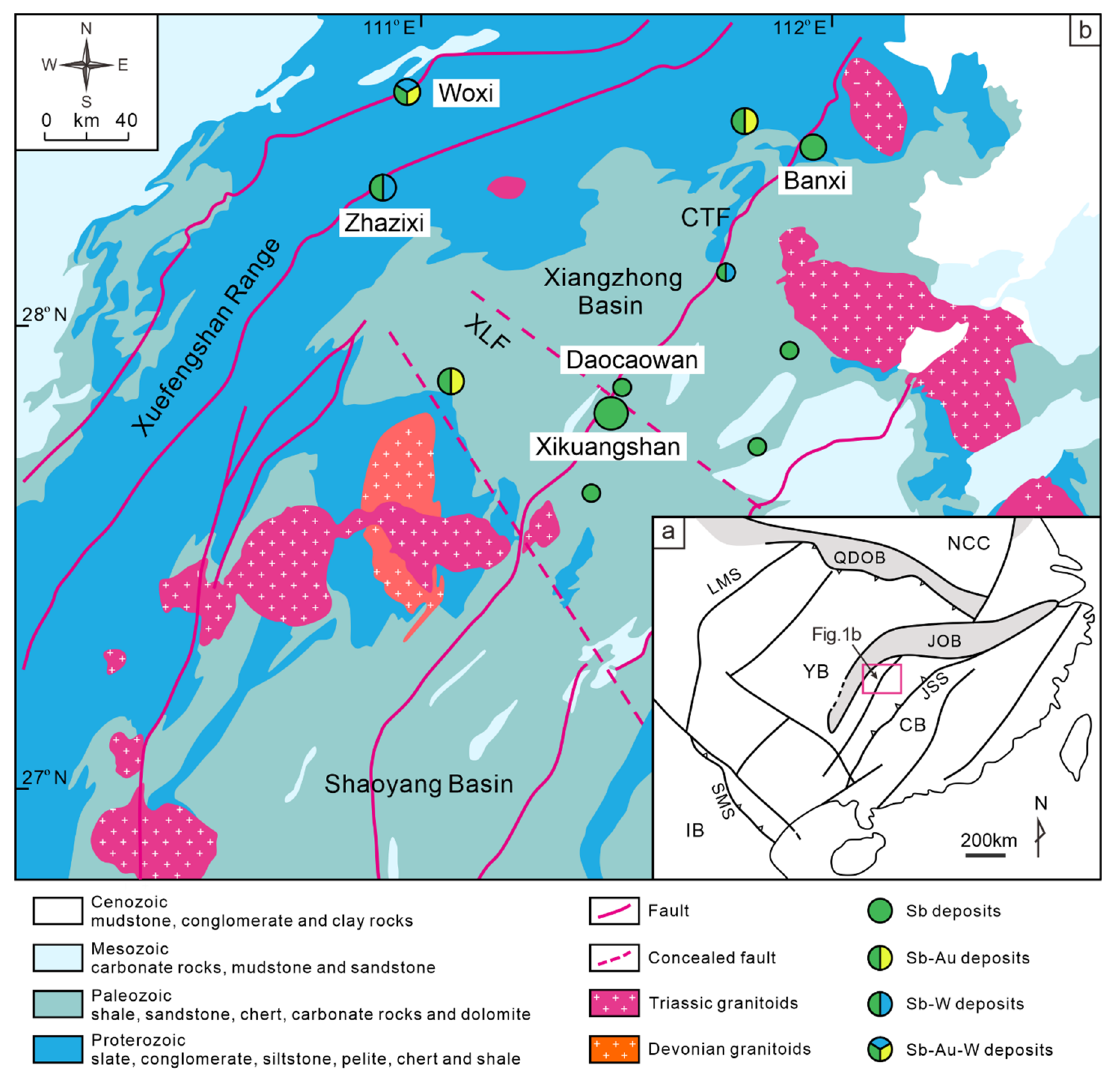
Figure 1. ( a ) Tectonic framework of the South China Block (Modified from [7,30]). Abbreviations: NCC = North China Craton, QDOB = Qinling ‐ Dabie Orogen Belt, LMS = Longmenshan Fault, JOB = Jiangnan Orogen Belt, YB = Yangtze Block, JSS = JiangShao Suture, CB = Cathaysia Block, SMS = Song ‐ MA Suture, IB = Indochina Block. ( b ) Regional geological map and distribution of some antimony ores in Central Hunan (Modified from [7,30]). XLF = Xinhua ‐ Lianyuan Fault, CTF = Chengbu ‐ Taojiang Fault.